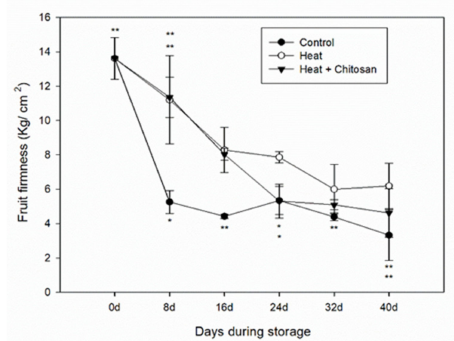
Figure 1. Fruit firmness of ‘Sanhua’ plum fruit during storage. Error bars represent for standard errors. Control: fruits without treatment; Heat: fruits with hot air treatment at 37 ◦ C for 6 h; Heat and Chitosan: fruits treatment with hot air (37 ◦ C, 6 h) and 1% chitosan. * and ** mean significant di ff erences at p < 0.05 and p < 0.01 level, respectively.